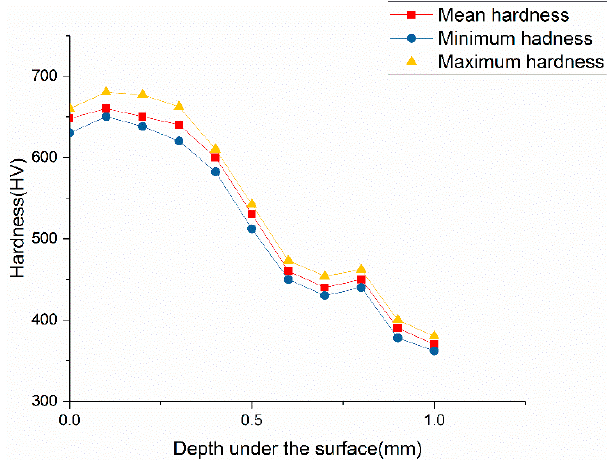
Figure 5. The hardness of the hardening layer.